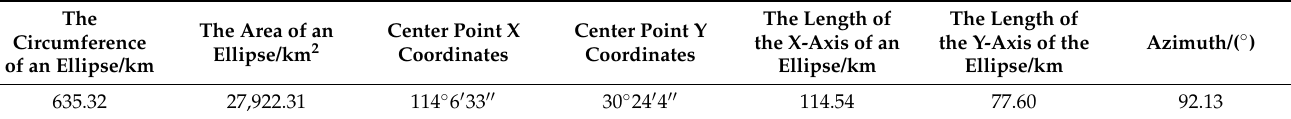
Table 4. Standard deviation ellipse parameters for friction (cost)